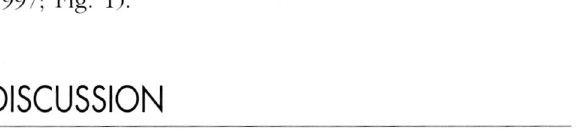
Table III. - Length of antenna 4 and wings of four Chinese Adle­ rius.